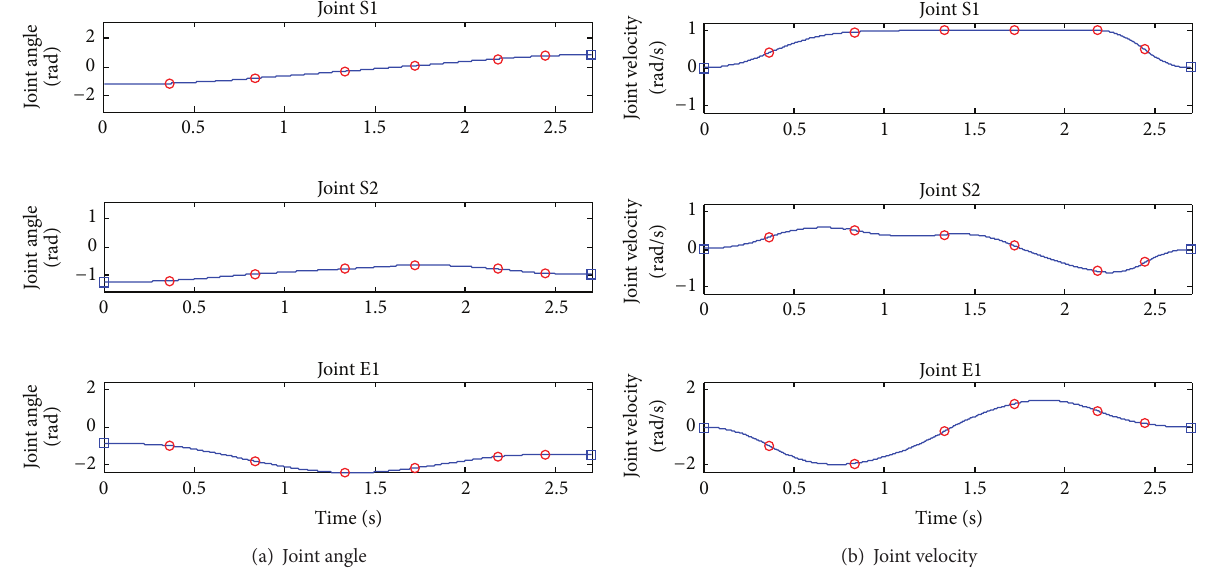
Figure 7: Trajectory of example case of translational motion: (a) joint angle (b) joint